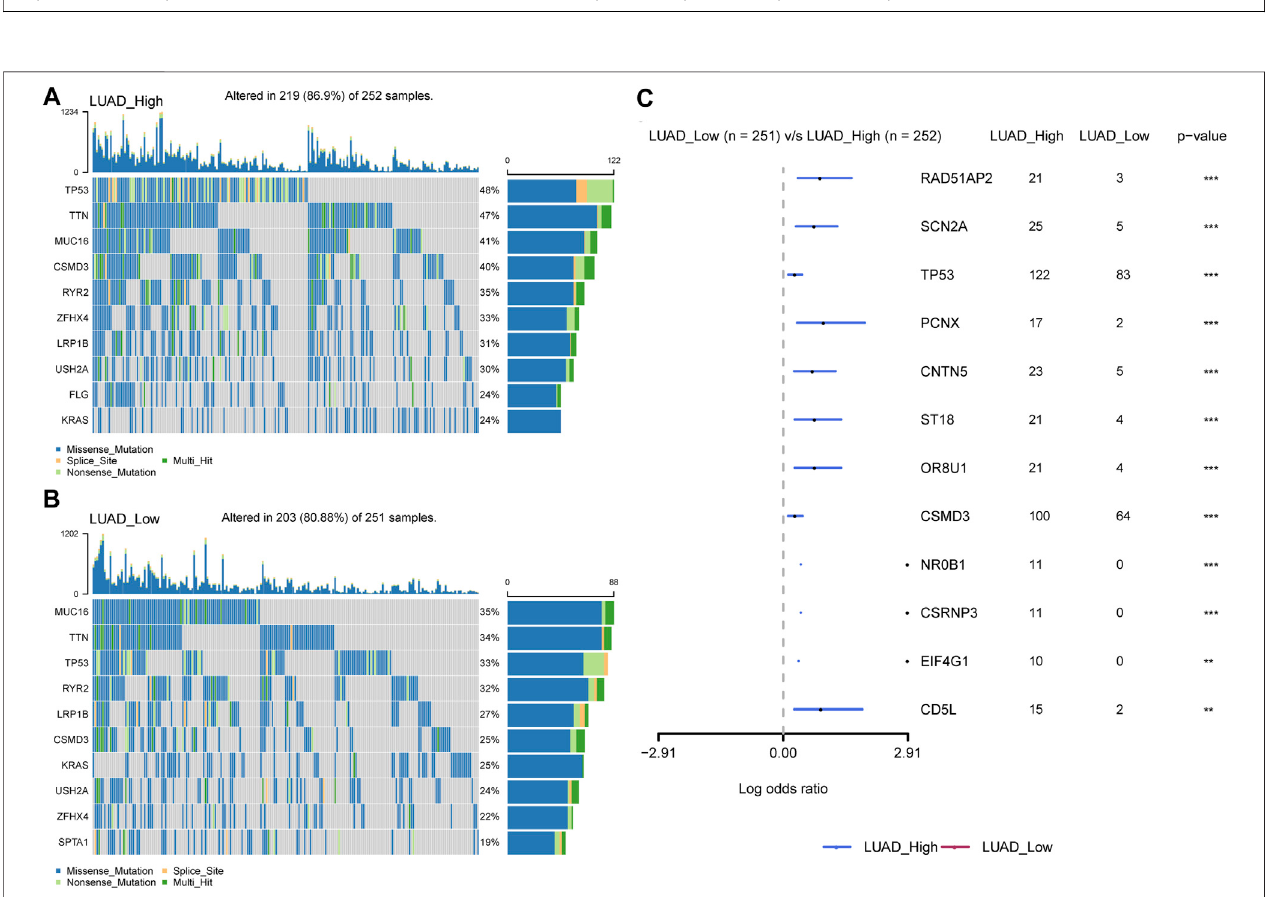
FIGURE11| ThecorrelationofP4HA1 expression with TMB and MSI. (A – B) Radar plots represent thecorrelationof P4HA1 expression with TMB (A) and MSI (B) in pan-cancer. The position of the red dot shows the correlation coef fi cient. * p < 0.05, ** p < 0.01, *** p < 0.001, **** p < 0.0001.